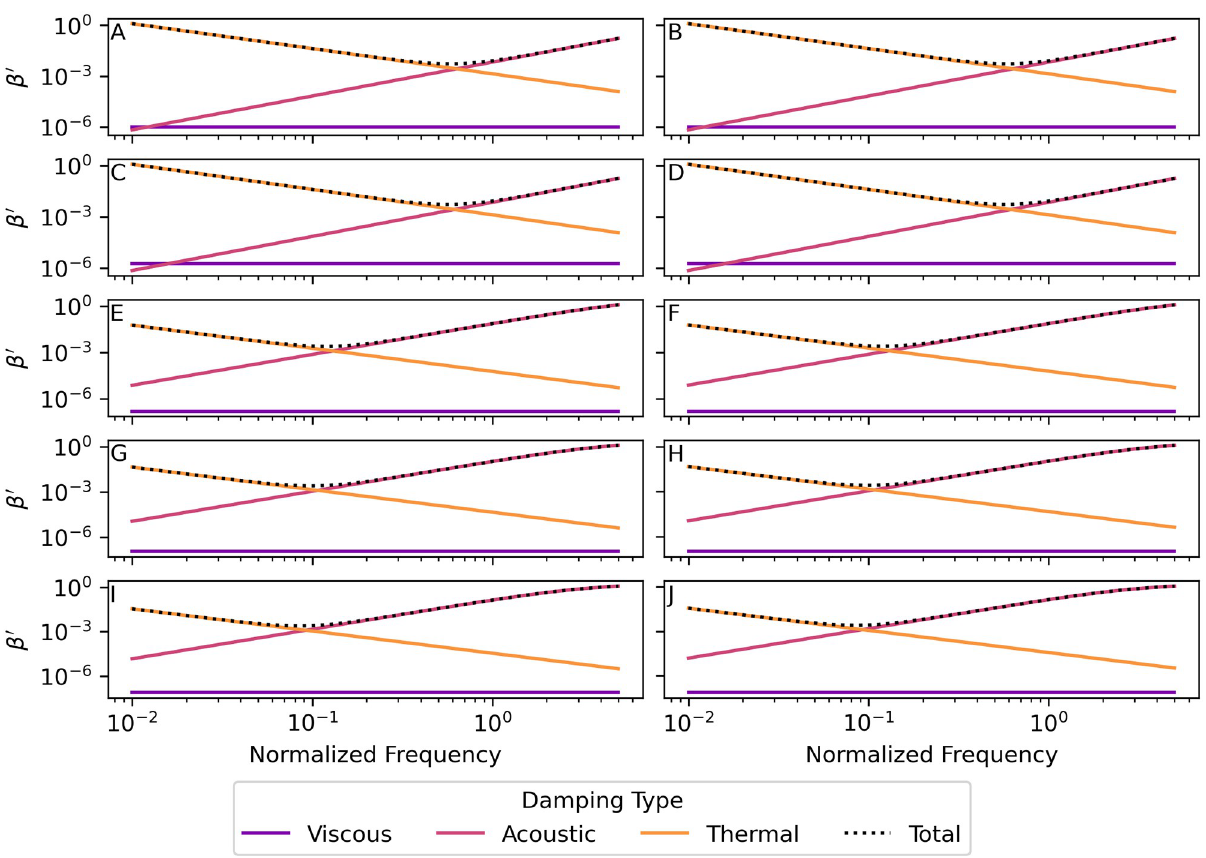
Fig 5. Viscous, acoustic, and thermal contributions to the normalized damping factor β 0 . The three parts of the normalized damping factor–viscous b 0 ¼ b = o , acoustic b 0 ¼ b = o , and thermal b 0 ¼ b = o damping–plotted vs. normalized frequency f 0 for a bubble of radius 0.10 m. vis und ac und th und vis ac th Parameter values for each environment are given in Table 1. (A) Nitrogen bubbles in the warm-surface environment. (B) Oxygen bubbles in the warm- surface environment. (C) Nitrogen bubbles in the cold-surface environment. (D) Oxygen bubbles in the cold-surface environment. (E) Nitrogen bubbles in the 1000 m deep environment. (F) Oxygen bubbles in the 1000 m deep environment. (G) Nitrogen bubbles in the 2000 m deep environment. (H) Oxygen bubbles in the 2000 m deep environment. (I) Nitrogen bubbles in the 3500 m deep environment. (J) Oxygen bubbles in the 3500 m deep environment. See sections 8.6 and 8.7 in S3 and S4 Files for the calculations used for this plot.